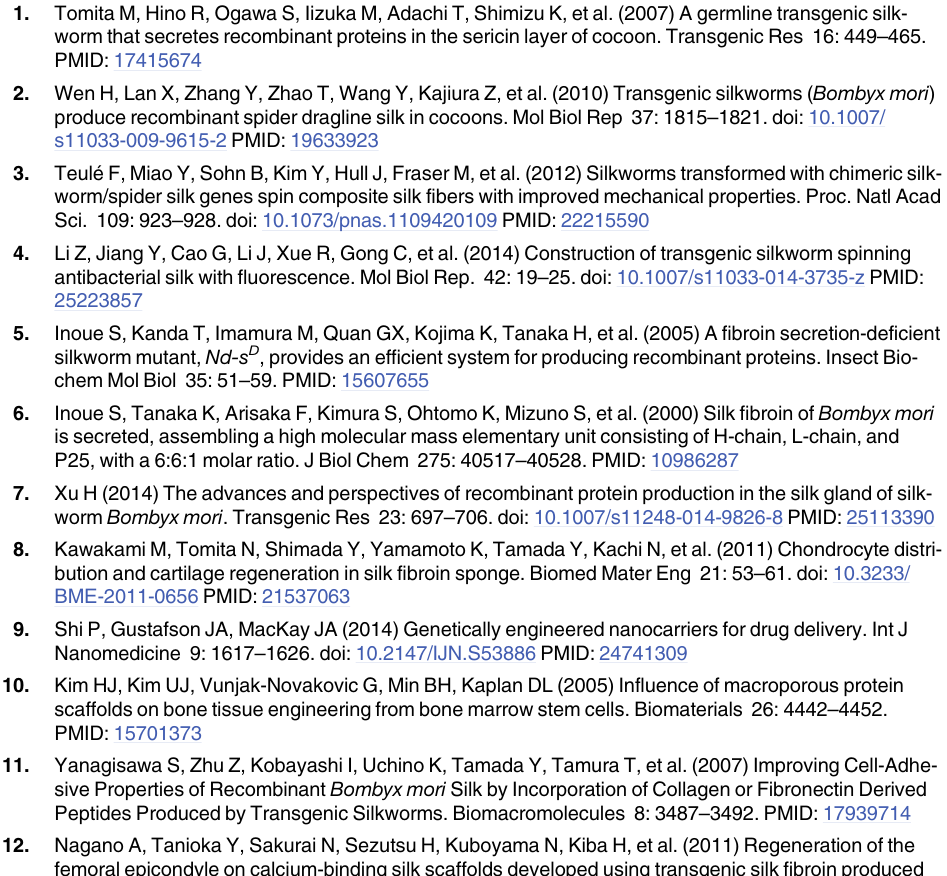
S2 Table. The MS/MS identification results of band A in Fig 3. (XLSX) S3 Table. The MS/MS identification results of band B in Fig 3. (XLSX) S4 Table. The MS/MS identification results of point C in Fig 3.